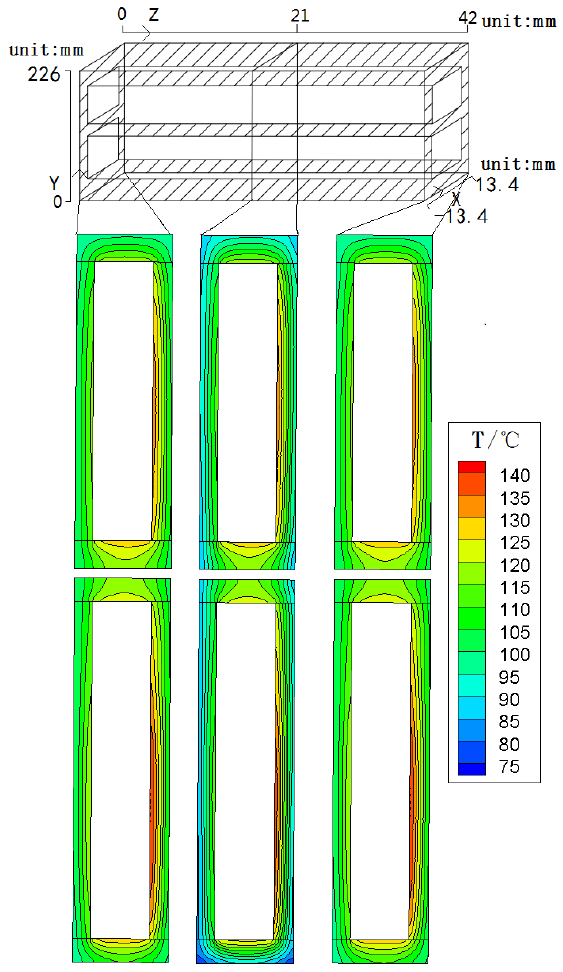
Figure 10. The main insulation temperature distribution along the circumferential–radial in the case of the stator main insulation unilateral shelling δ = 0.5 mm.